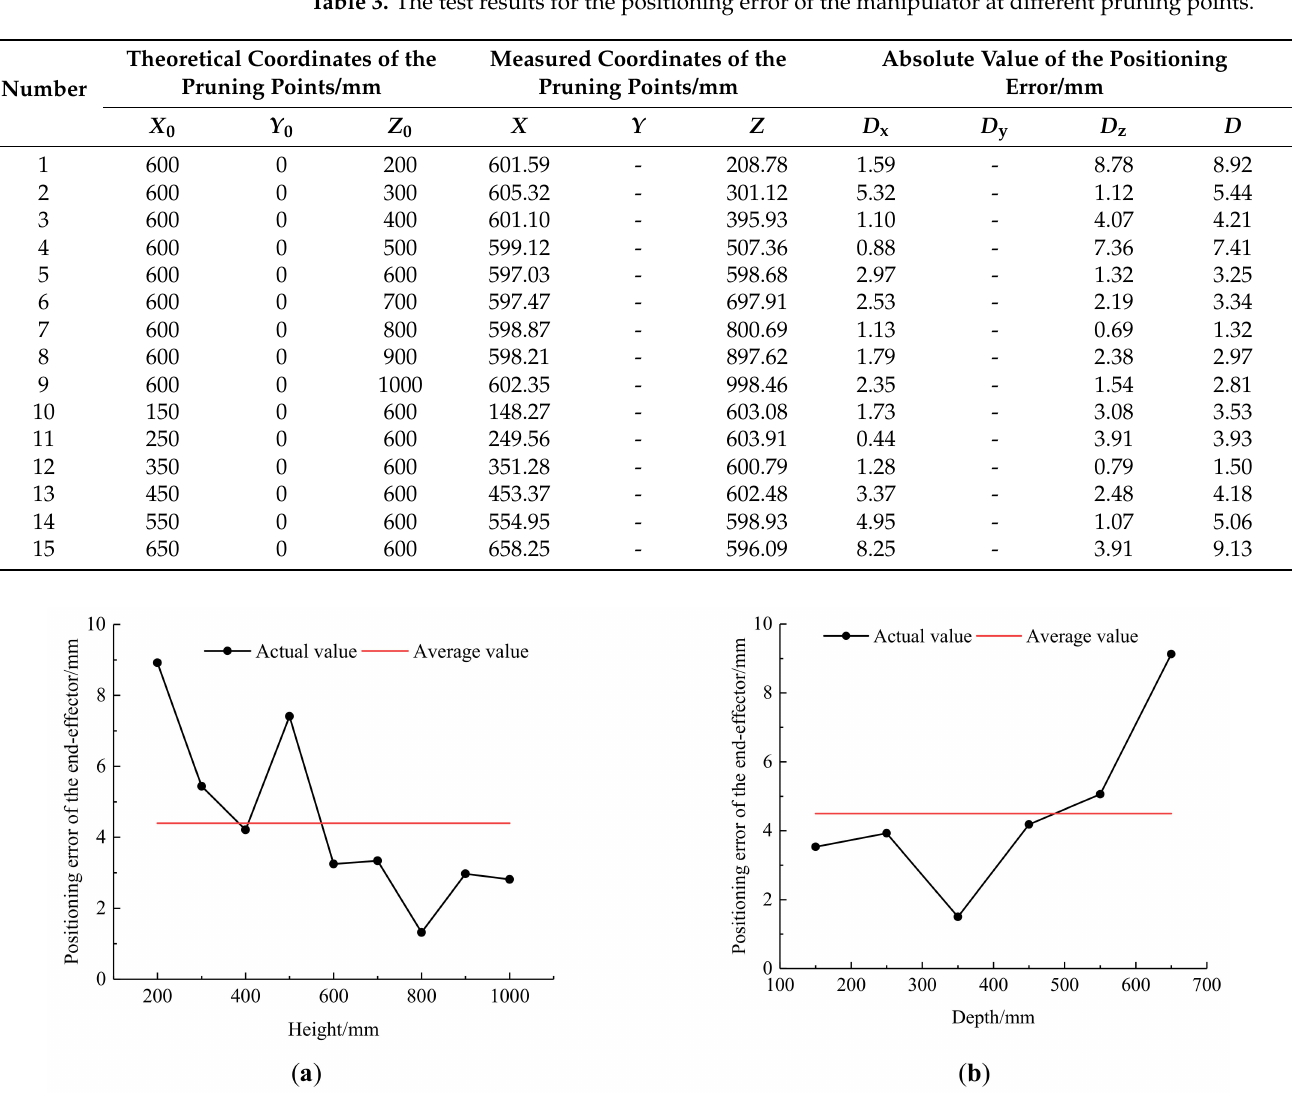
Figure 14. The schematic diagram of the positioning error trend for the manipulator end-effector. ( a ) Positioning error at different heights, and ( b ) positioning error at different